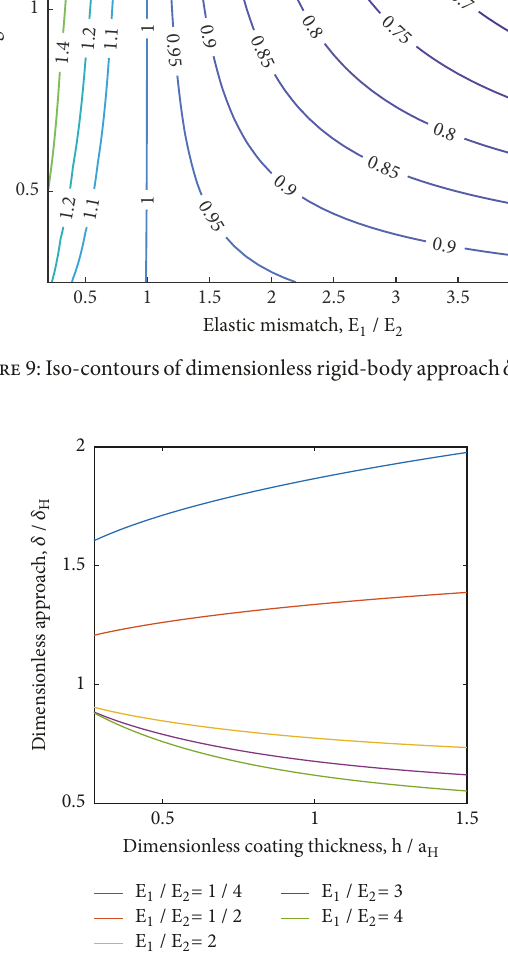
Figure 10: Influence of coating thickness on the dimensionless rigid-body approach 𝛿/𝛿 𝐻